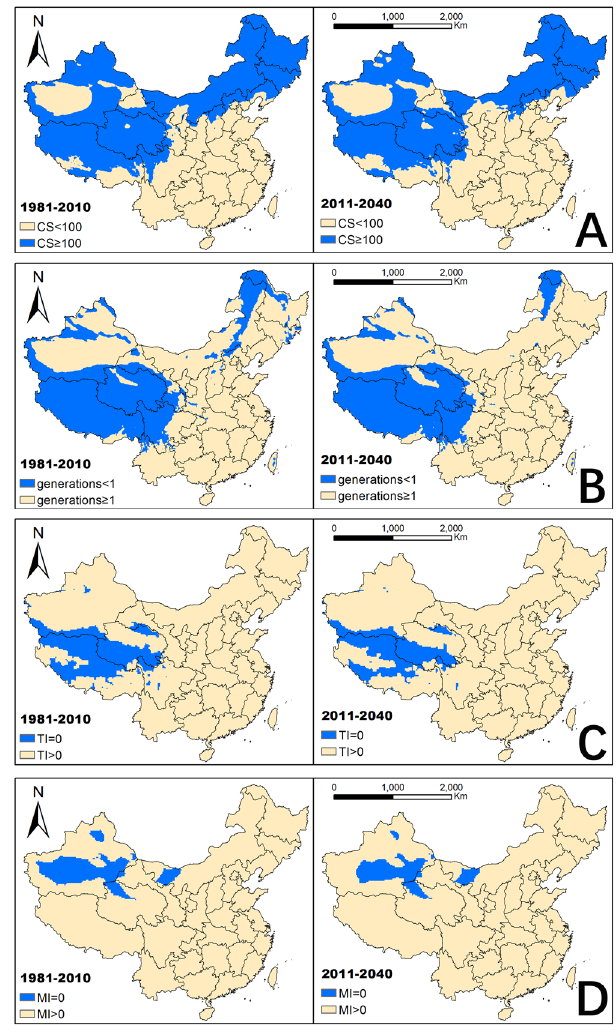
Figure 2. Limiting distribution maps of four different conditions. ( A ) The regions with cold stress (CS) were shown in blue. ( B ) The regions shown in blue couldn’t support for Euwallacea fornicates to complete a generation. ( C ). The regions where the Temperature Index (TI) were unsuitable for its survive shown in blue. ( D ) The regions where the Mositure Index (MI) were unsuitable for its survive shown in blue. The related values were exported into GIS software (ArcGIS for Desktop, Software Version 10.2, http://resources.arcgis.com/en/ home/) to generate the map in this